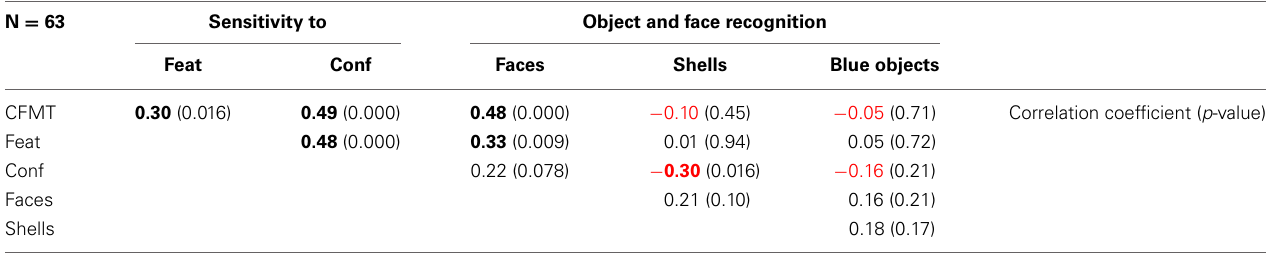
Depicted are the correlation coefficient, and in parentheses the p-value of the coefficient. Negative correlations are marked in red, significant correlations are written in bold letters. (CFMT, final score; Feat, sensitivity to featural changes in a face; Conf, sensitivity to configural changes in a face; Shells, Faces, Blue objects: d (cid:2) values for shells, faces and the blue objects in the object recognition